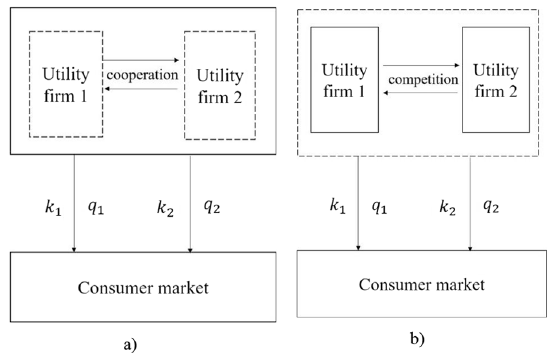
Fig. 1 Decisions of the duopoly in a cooperative and b competitive electricity